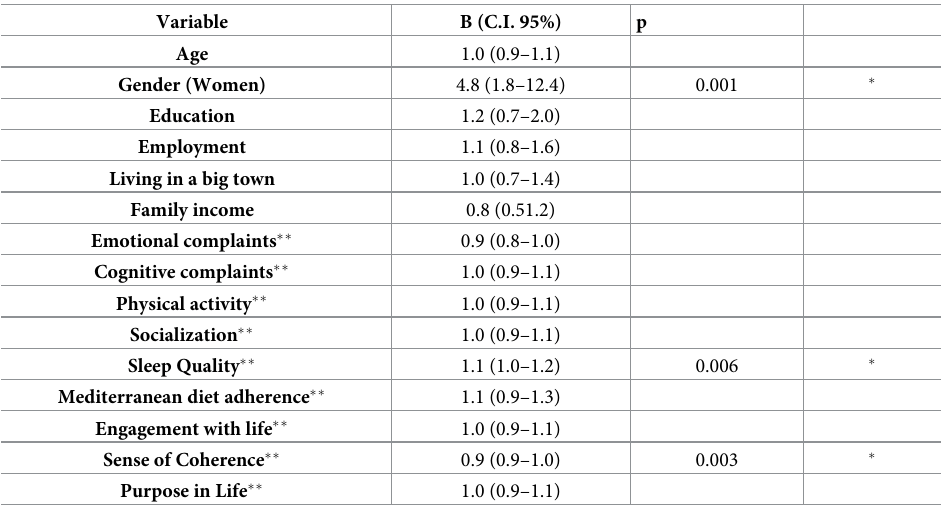
Table 9. Multiple logistic binomial regression using new diagnosis of depression as dependent variable and base- line characteristics of participants as independent variables. Reported values are standardized beta